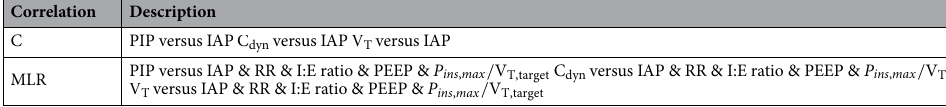
Table 8. The analysed linear regression correlations, where PIP is the peak airway pressure, C dyn is the dynamic lung compliance, RR is the respiration rate, I:E ratio is the inspiration/expiration ratio, PEEP is the positive end expiratory pressure, P ins , max is the pre-set inspiration pressure for PCV mode, V T,target is target tidal volume for VCV mode, and IAP is the intra-abdominal